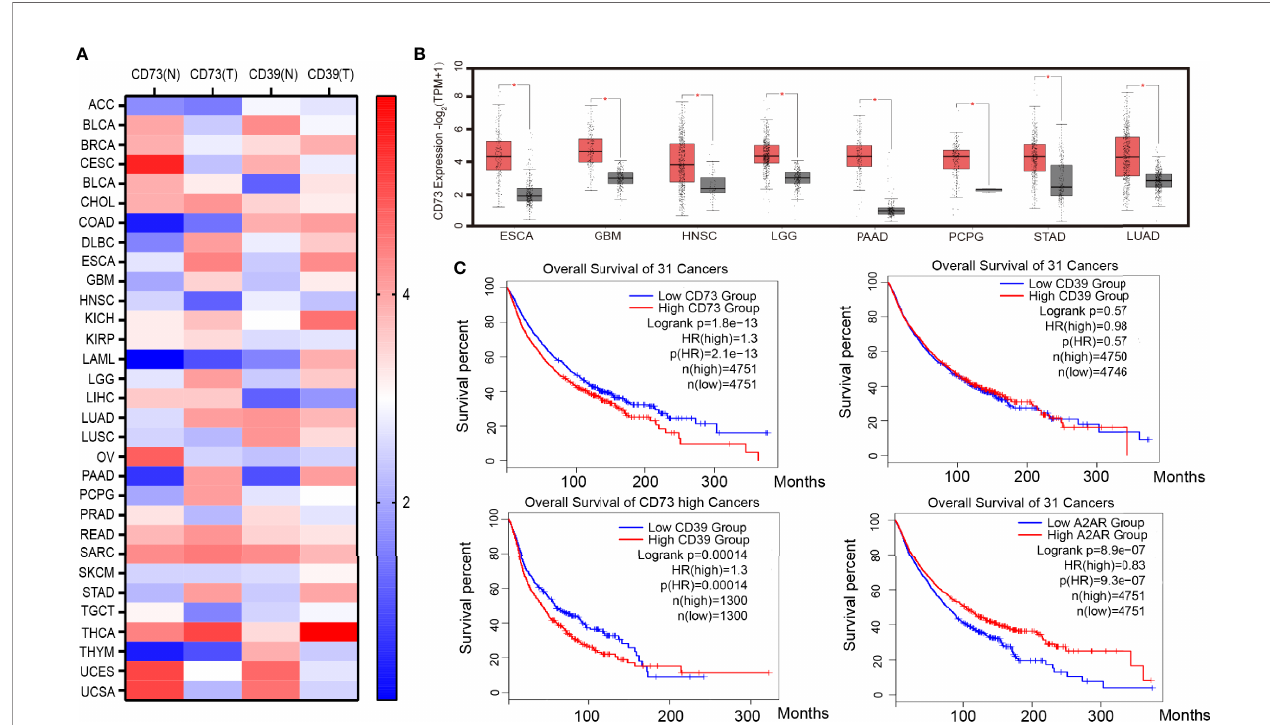
FIGURE 1 | CD39, CD73, and A2AR expression and survival in cancer. (A) Heat map of CD39 and CD73 genes expressed in 31 kinds of tumor tissue and corresponding normal tissue. (B) Cancers with signi fi cantly high expression of the CD73 gene. (C) Survival analysis of cancer patients with high or low CD39, CD73 and A2AR genes expression. Data from the TCGA and GTEx studies on RNA sequencing expression in 9,736 cancers and 8,587 normal samples. ACC (Adrenocortical carcinoma), BLCA (Bladder Urothelial Carcinoma), BRCA (Breast invasive carcinoma), CESC (Cervical squamous cell carcinoma and endocervical adenocarcinoma), CHOL (Cholangio carcinoma), COAD (Colon adenocarcinoma), DLBC (Lymphoid Neoplasm Diffuse Large B-cell Lymphoma), ESCA (Esophageal carcinoma), GBM (Glioblastoma multiforme), HNSC (Head and Neck squamous cell carcinoma), KICH(Kidney Chromophobe), KIRC (Kidney renal clear cell carcinoma), KIRP (Kidney renal papillary cell carcinoma), LAML (Acute Myeloid Leukemia), LGG (Brain Lower Grade Glioma), LIHC (Liver hepatocellular carcinoma), LUAD (Lung adenocarcinoma), LUSC (Lung squamous cell carcinoma), MESO (Mesothelioma), OV (Ovarian serous cystadenocarcinoma), PAAD (Pancreatic adenocarcinoma), PCPG (Pheochromocytoma and Paraganglioma), PRAD (Prostate adenocarcinoma), READ (Rectum adenocarcinoma), SARC (Sarcoma), SKCM (Skin Cutaneous Melanoma), STAD (Stomach adenocarcinoma), TGCT (Testicular Germ Cell Tumors), THCA (Thyroid carcinoma), THYM (Thymoma), UCEC (Uterine Corpus Endometrial Carcinoma), UCS (Uterine